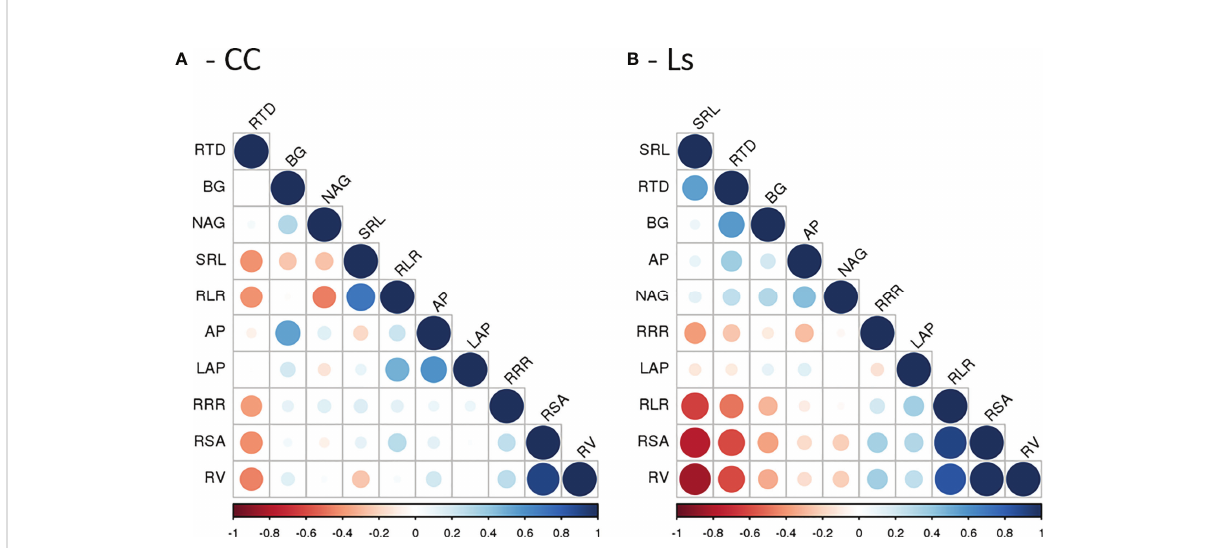
FIGURE 5 Pearson correlation matrix of morphological/architectural root traits (RV, RSA, RLR, RTD, and SRL), root respiration rate (RRR), and the potential root enzyme activities (AP, BG, LAP, and NAG) for (A) Cucurbita maxima × Cucurbita moschata and (B) Lagenaria siceraria self-grafted plants and respective heterografts with melon and watermelon. See text for details.